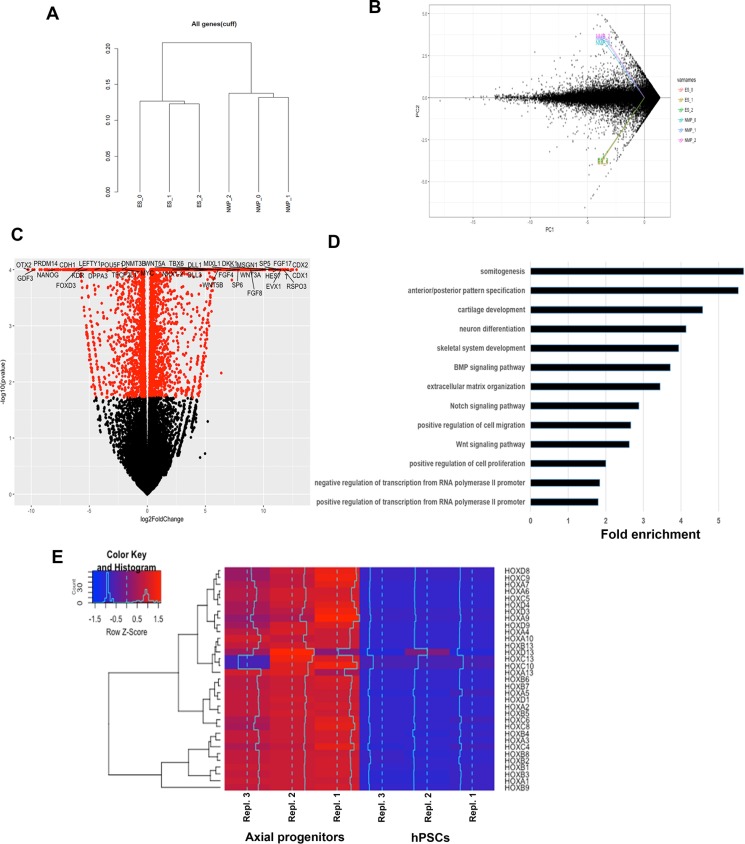
RNASeq analysis of in vitro-derived axial progenitors.(A) Dendrogram showing the clustering of the individual axial progenitor (NMP) and hESC sample replicates based on RNAseq expression data. (B) Principal Component Analysis (PCA) plot indicates a good separation, in terms of gene expression, between the two conditions and a good replication among samples. (C) Volcano plot reporting pvalue (y axis) as a function of log2 fold change (x axis) between the axial progenitor and hPSC groups. The red dots depict significant genes (pvalue <= 0.05). Top differentially expressed transcriptional regulators of axis elongation and WNT/FGF/NOTCH/RA signalling pathway components are shown. (D) Top gene ontology groups significantly enriched in axial progenitors vs hPSCs. (E) Hierarchical clustering heatmap showing the expression values of HOX genes in axial progenitor and hPSC sample replicates. The expression values (FPKM) were scaled to the row mean. The color key relates the heat map colors to the standard score (z-score).